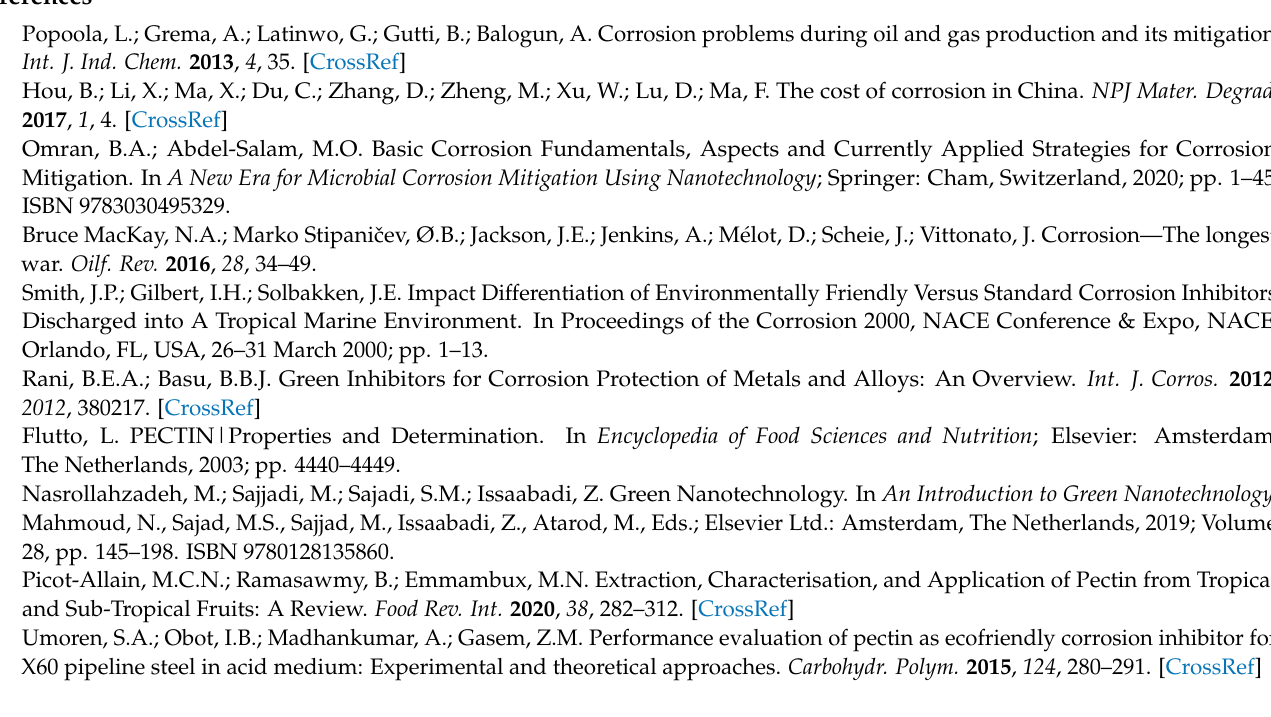
and finally, its value was